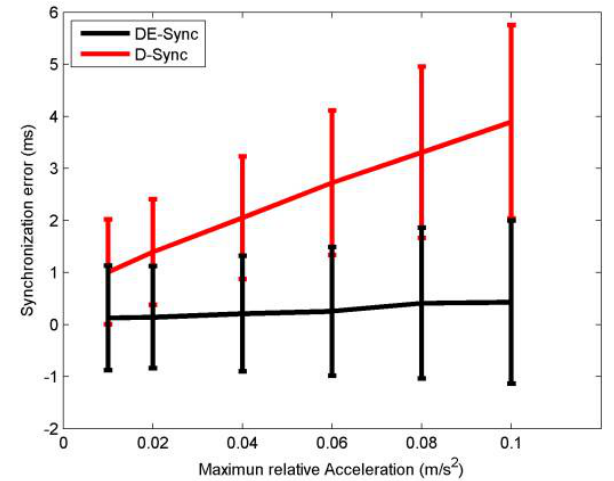
Figure 6. Performance with relative acceleration.